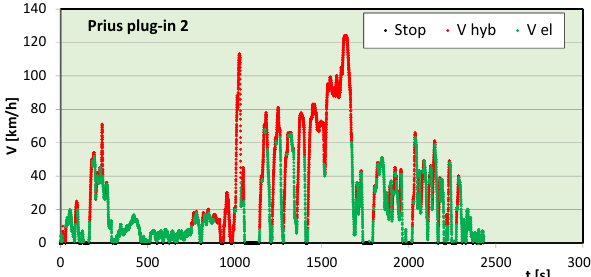
Fig. 9. Operational conditions of vehicles in electric (V el) and hybrid mode (V hyb) [11]